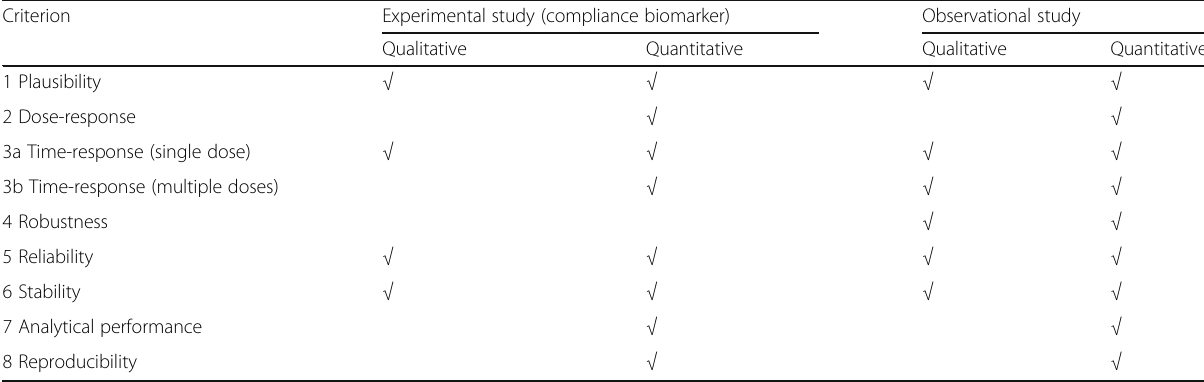
Table 3 Criteria need to be fulfilled for different uses of BFIs